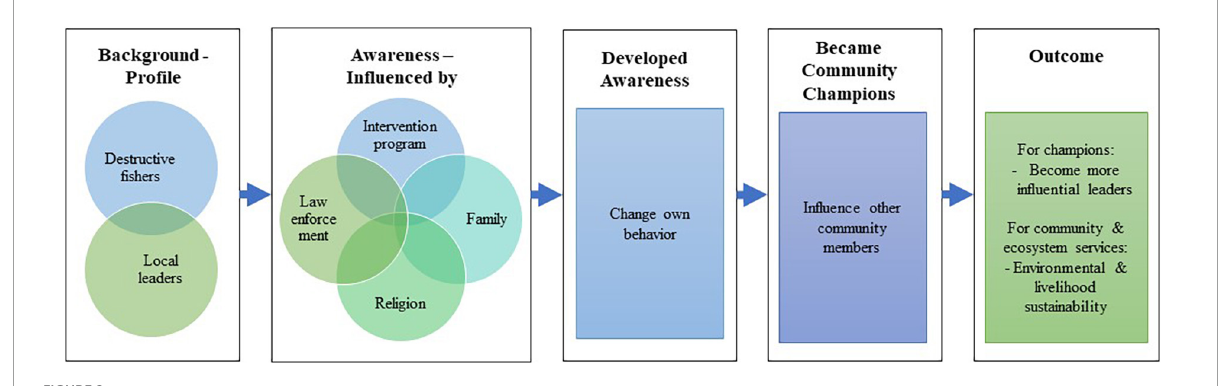
FIGURE2 Emergence process of community